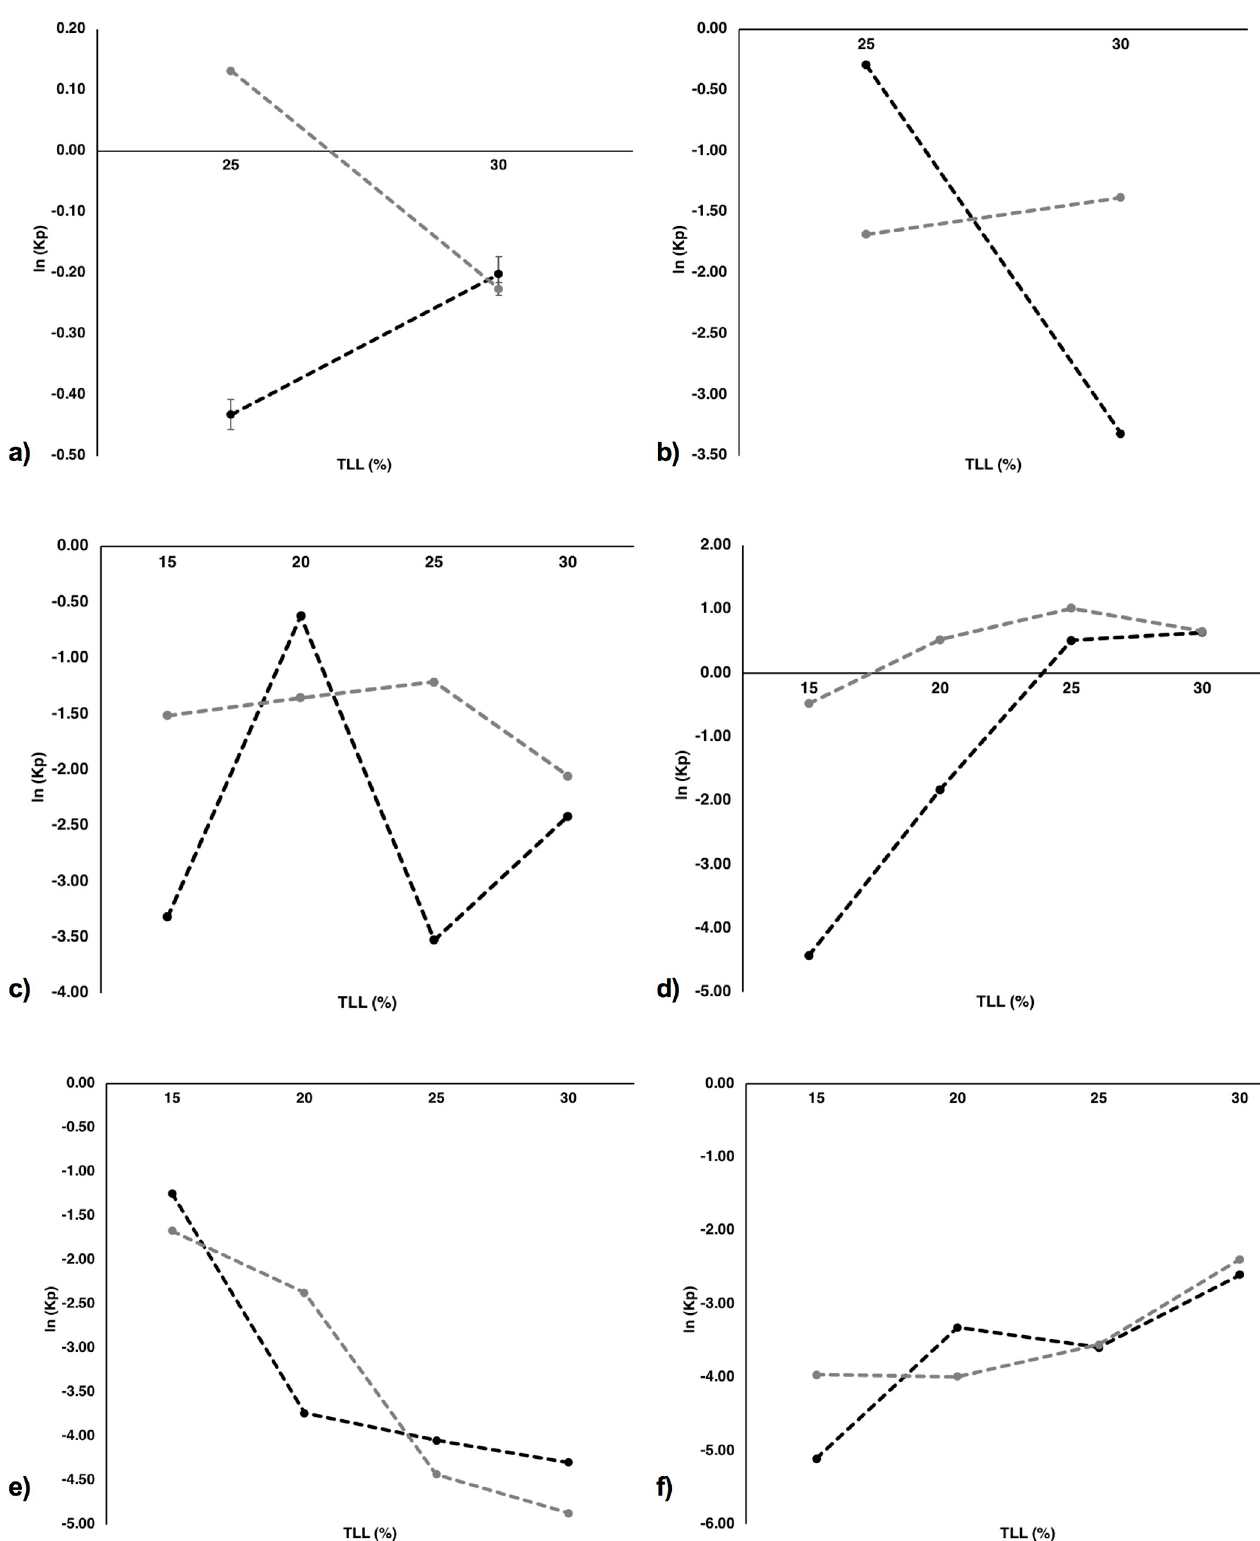
Fig 2. Effect of TLL (%) w/w on ln K P of exosomes and contaminants fractionation in aqueous two-phase systems. Ln K P values of exosomes () and contaminants () are shown for each system: a) PEG 3400 g mol -1—Dextran 10 g mol -1 , b) PEG 10000 g mol -1 —Dextran 10 g mol -1 , c) PEG 3400 g mol -1—